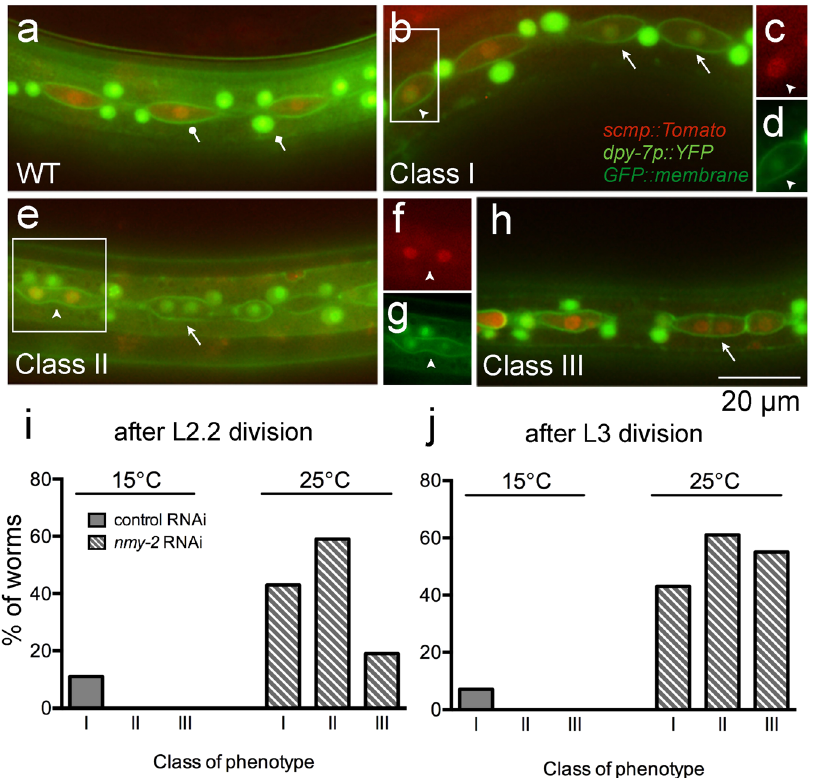
Figure 3. nmy-2 knockdown produces three distinct classes of cell fate mis-specification phenotypes. ( a ) The dual-colour fate reporter strain (AW1015) contains ouIs10 [ scmp::NLS::tdTomato; dpy-7p :: 2xNLS :: YFP ; wrt- 2p::GFP :: PH ] that marks the seam nuclei red (lollipop arrow) and the hypodermal nuclei green (diamond arrow). ( b – h ) nmy-2 knockdown produced distinct classes of fate transformation phenotypes (arrows and arrowheads) (strain AW1018). The animals shown here were imaged after the L2.2 asymmetric division. Arrows point to pertinent cells representing each Class; arrowheads point to cells clearly expressing both fate markers. ( c ) and ( d ) Are red and green channel images corresponding to the boxed area in ( b ), respectively; ( f ) and ( g ) are red and green channel images corresponding to the boxed area in ( e ), respectively. ( i , j ) The fate transformation phenotypes were quantified as a percentage of worms after the L2.2 and the L3 asymmetric divisions, by dividing the number of worm exhibiting each phenotype by the total number of worms